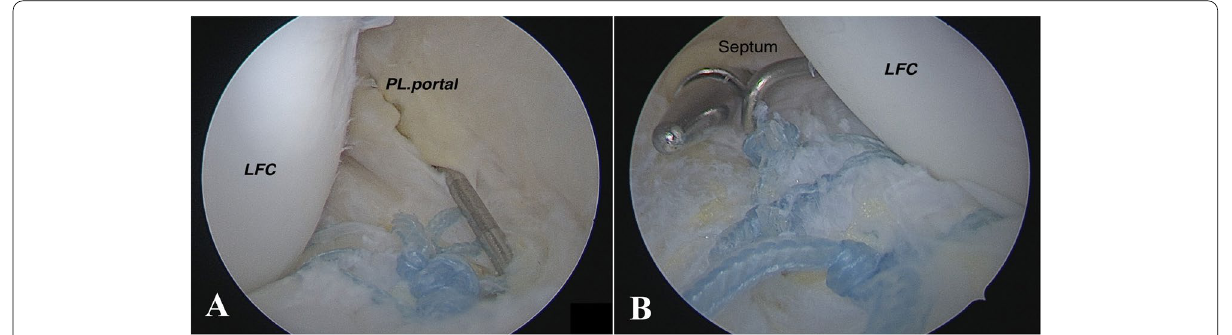
Fig. 3 Repaired lateral meniscus: A Posteromedial transseptal and B posterolateral views